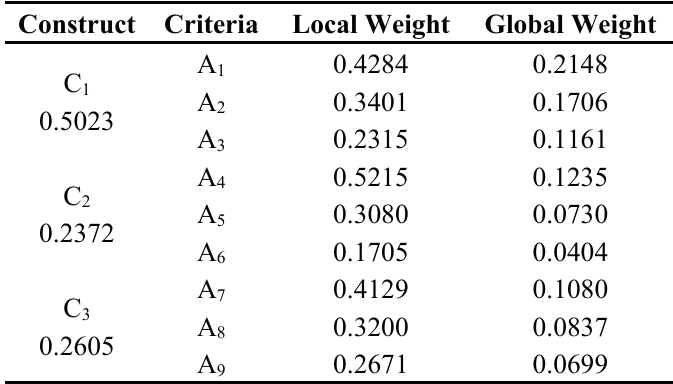
Table 12. The computed global weights for the attributes. Construct Criteria Local